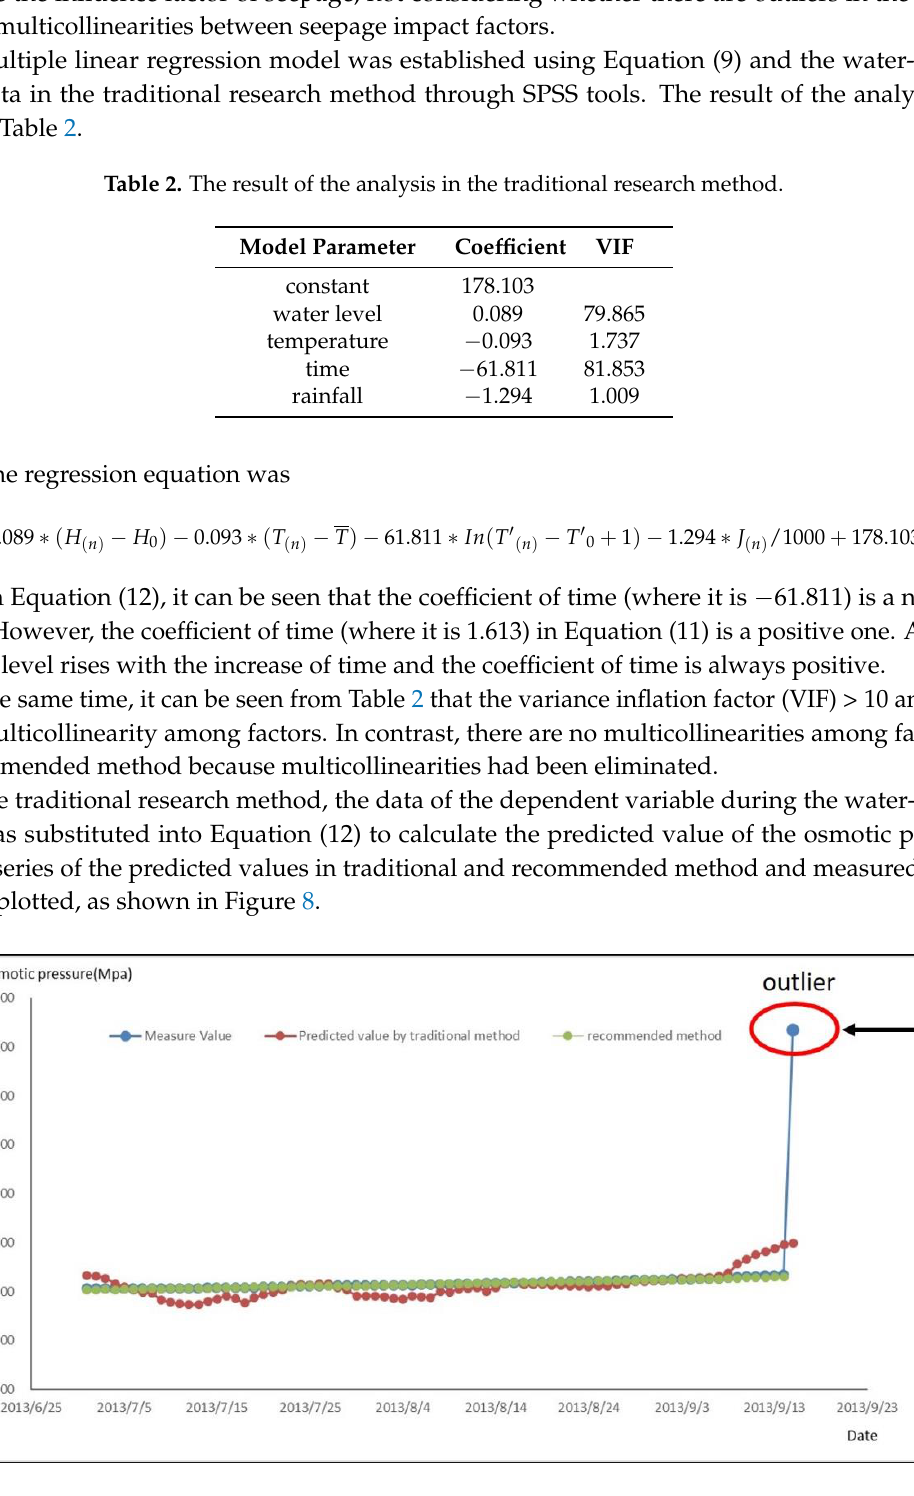
Figure 8. The Measure and Predicted Process Chart of Osmotic Pressure In Traditional and Recommended Method During Water-Storage Period.